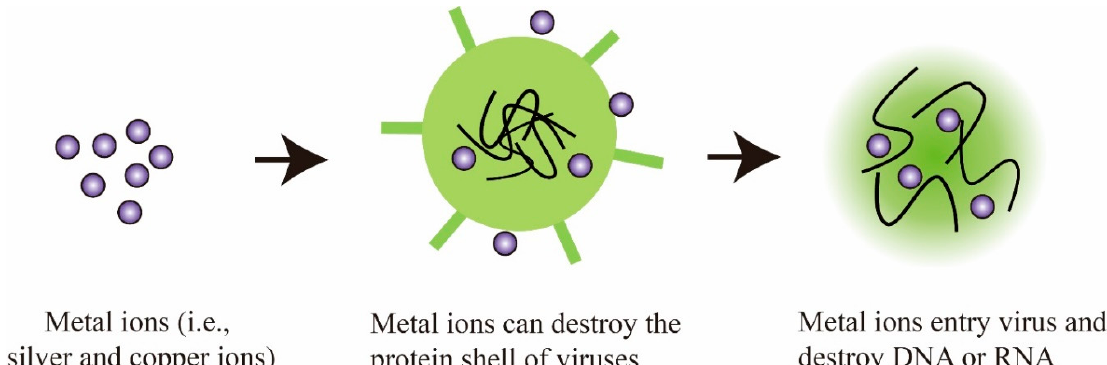
Figure 3. Schematic showing the antiviral mechanism of metal ions.